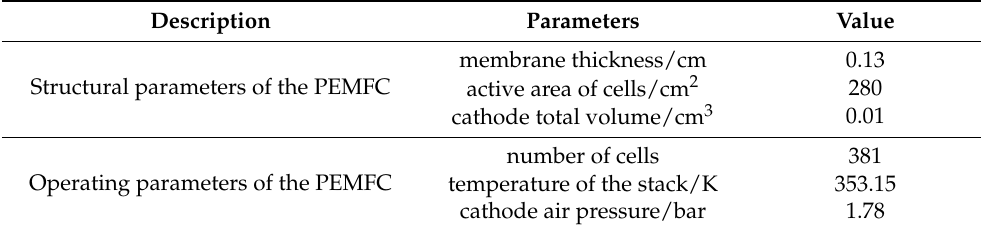
Table 1. Main parameters of PEMFC